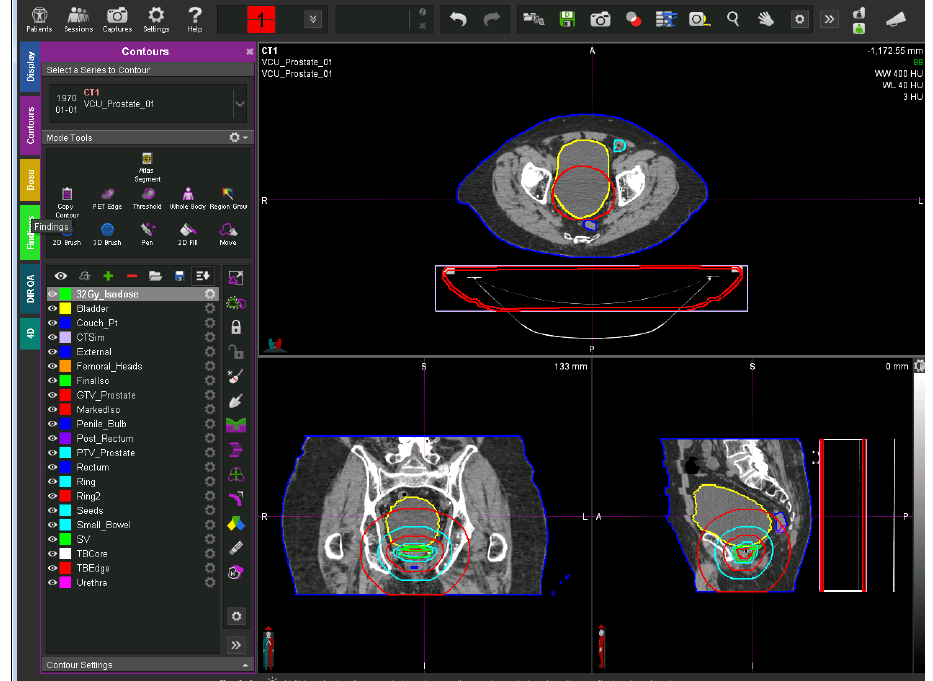
Figure 1. A representative CT image overlaid with its defined structures. The left side of the figure shows the physician-transcribed names of the structures delineated on the right side. The physician-transcribed names and structures delineated can be matched by the